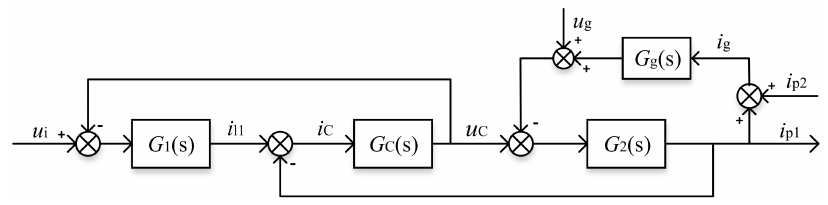
Figure 2. Equivalent block diagram of LCL inverter